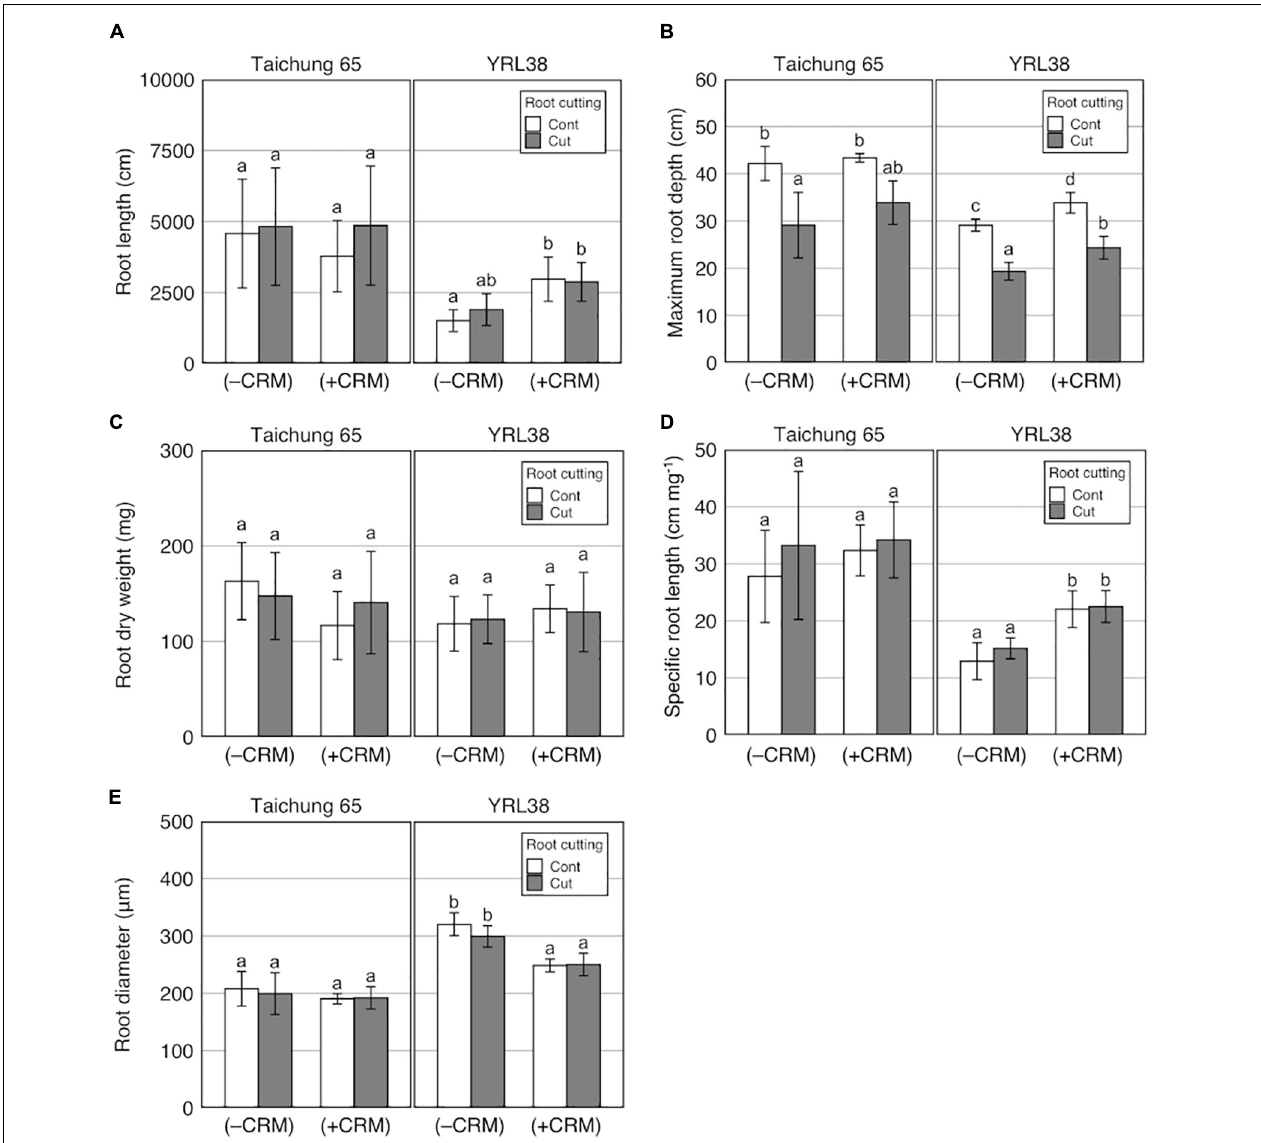
FIGURE 7 | Effect of CR number manipulation (CRM) on (A) TRL, (B) MRD, (C) RDW, (D) SRL, and (E) RD combined with root cutting in Taichung 65 and YRL38 grown in a semihydroponic phenotyping platform for 41 days after transplanting. Values represent mean ± SD ( n = 3–6). For each trait, bar data followed by different letters indicate significant differences among treatments in each genotype ( p <